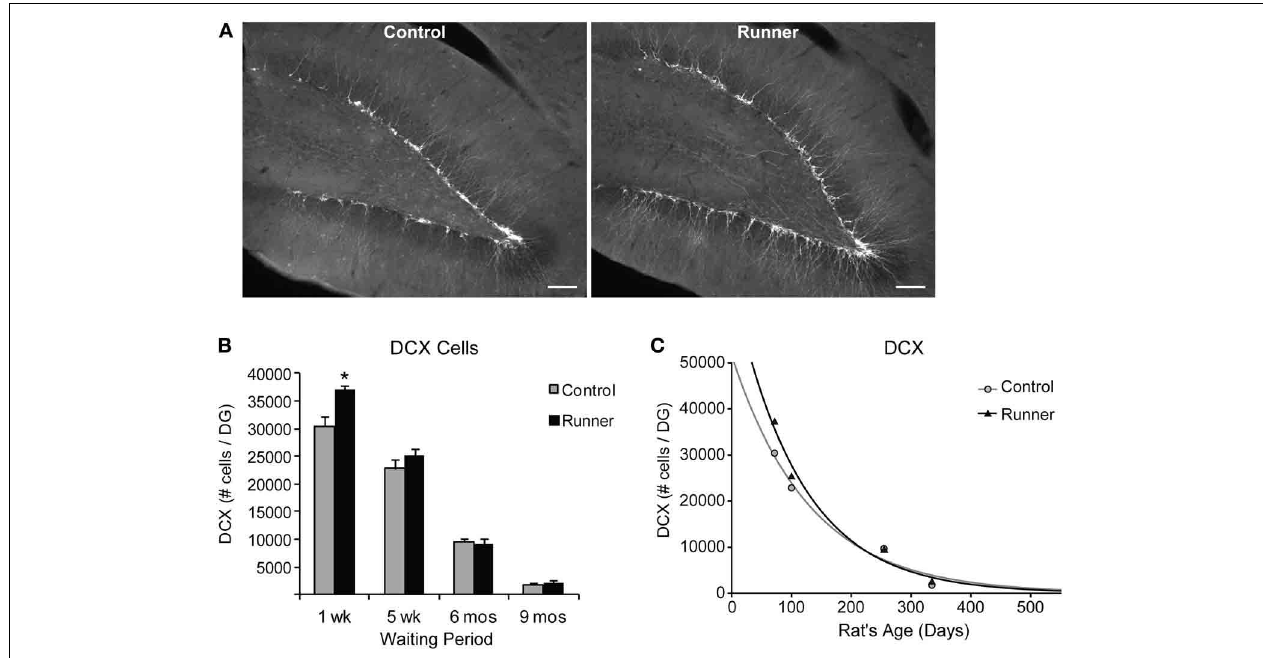
differences were detected between Runners and Controls at any other time point. (C) Exponential decay curve for DCX shows parameters a = 51 . 650 and b = 0 . 0077 in Controls and a = 67 . 680 and b = 0 . 0089 in Runners. This is consistent with the higher initial cell number at younger ages and slightly faster decay in runners compared with controls.